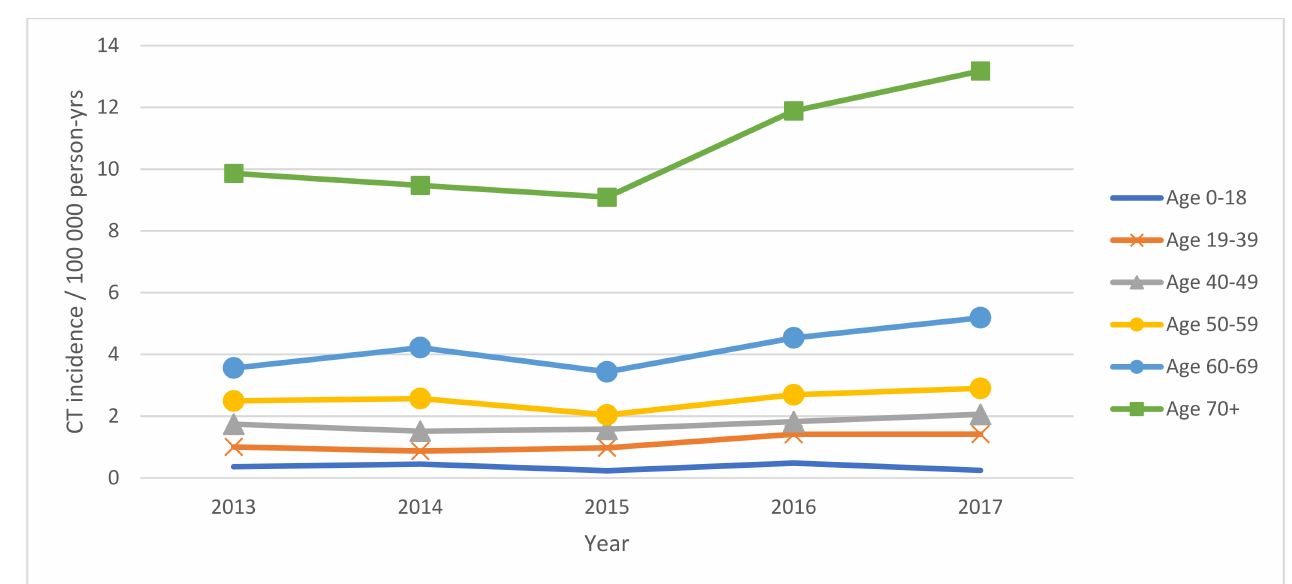
Figure 1. Incidence of corneal grafts in age groups in Poland during 2013–2017.